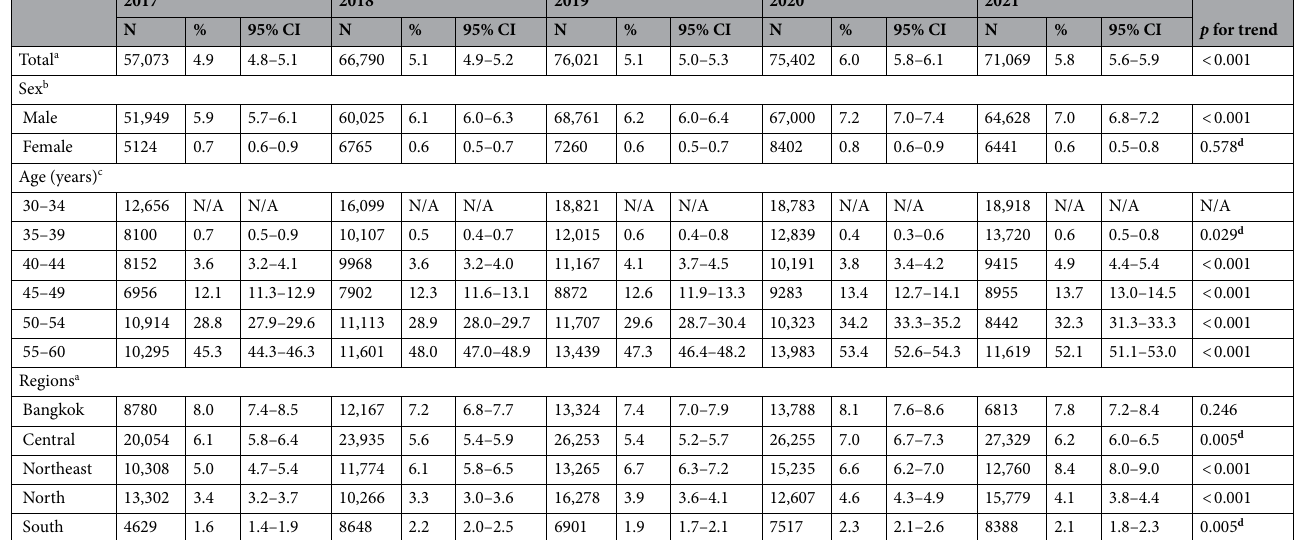
Table 4. Prevalence of high predicted 10-year risk for CVD among RTA personnel, from 2017 to 2021. a Age- and sex adjusted prevalence using regression analyses. b Age-adjusted prevalence using regression analyses. c Sex-adjusted prevalence using regression analyses. d Nonlinear trend. CVD cardiovascular diseases, RTA Royal Thai Army, 95% CI 95% confidence